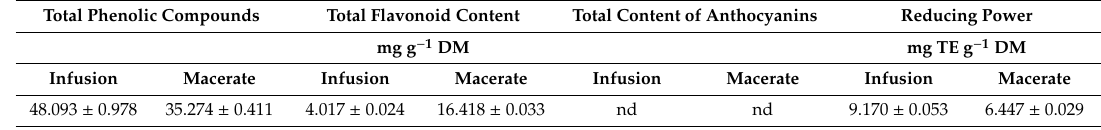
Table 1. Antioxidant potential of extracts from A. vulgaris